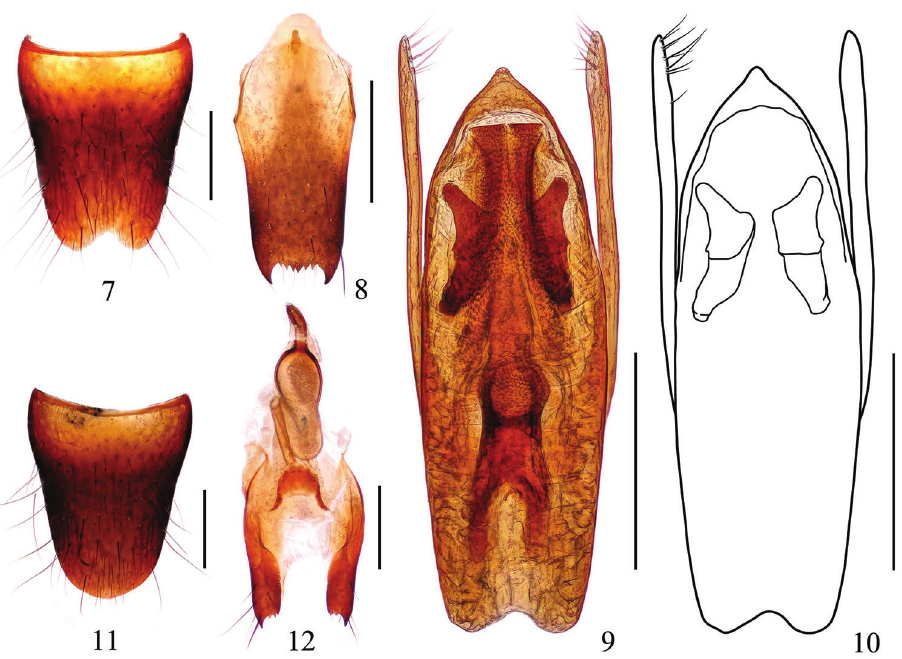
Figures 7–12. Stenus dashaheensis sp. n. 7 male sternite VIII 8 male sternite IX 9, 10 aedeagus. 11 female sternite VIII 12 valvifers and spermatheca. Scale bars: 0.25